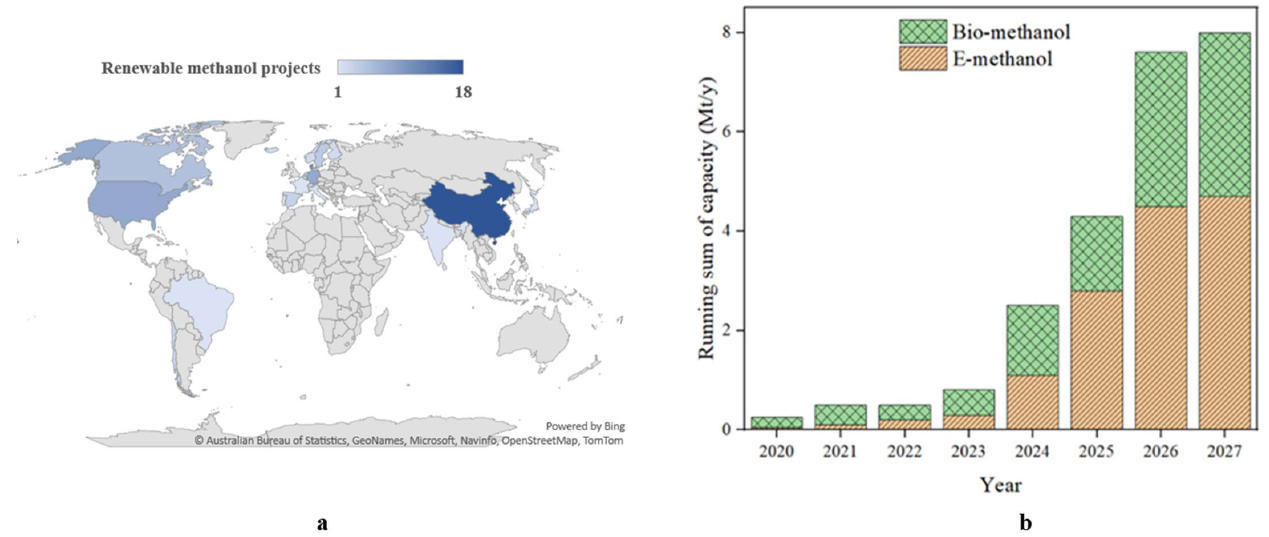
Figure 7. ( a ) Countries by the count of existing renewable methanol projects; ( b ) projected renewa- ble methanol production capacity by start-up year. Based on data from Ref. [46].